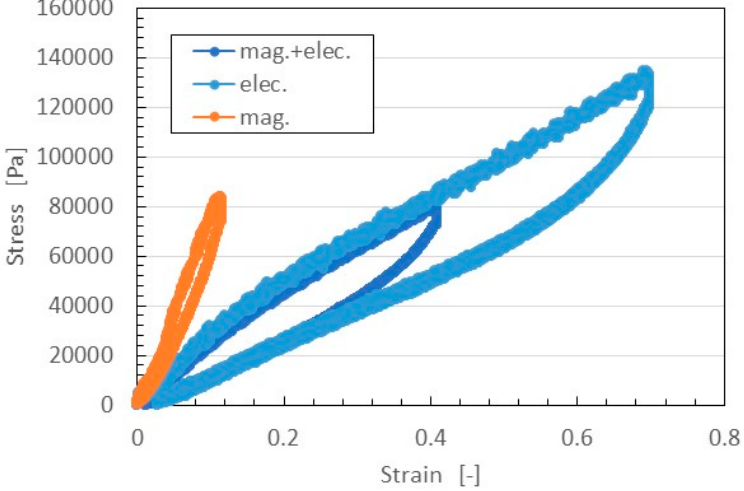
Figure 11. Relation between strain and stress of MCF rubber by tensile testing machine.